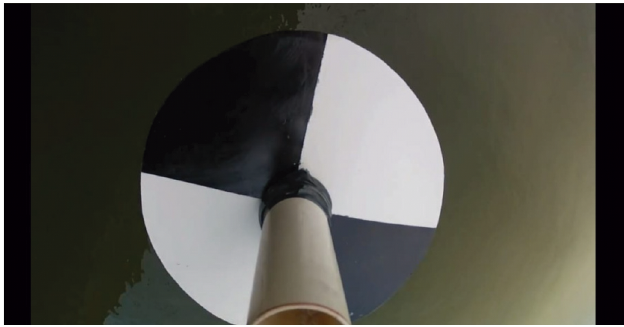
Figure 5. Natural interactions of the Secchi Disk resizing